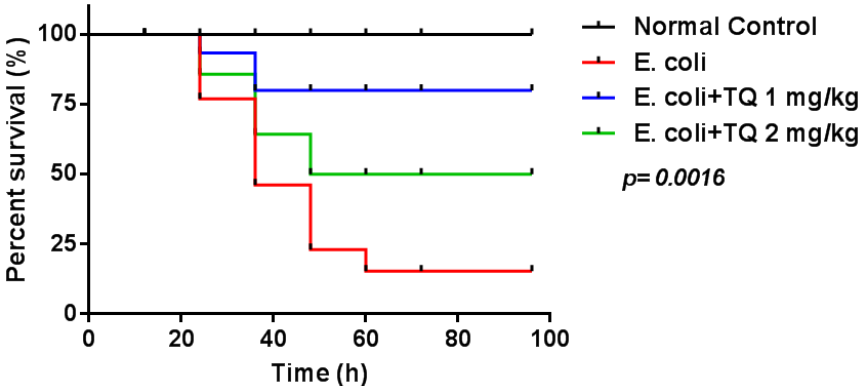
Figure 1. Kaplan – Meier survival plot following E. coli ( n = 12 mice per group). Mice were challenged with live E. coli and thymoquinone (TQ) was administered two hours after sepsis induction.